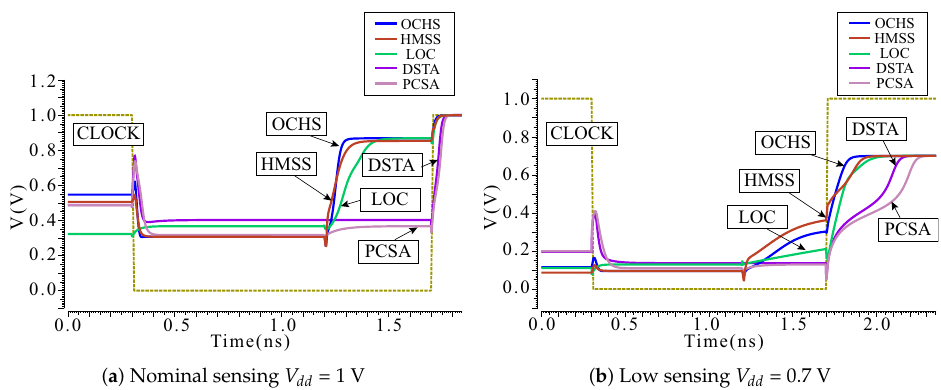
Figure 3. Sensing antiparallel (AP) as an example, simulated sensing operation waveform of OCHS, HMSS, LOC, DSTA and PCSA designed with 28-nm complementary metal-oxide-semiconductor (CMOS) with ( a ) nominal sensing V dd = 1 V and ( b ) low sensing V dd = 0.7 V. Pre-charge, sensing and amplified phases are sequentially demonstrated. The dotted line represents the sensing clock signal. DDRS waveform is separately demonstrated in Figure 4.